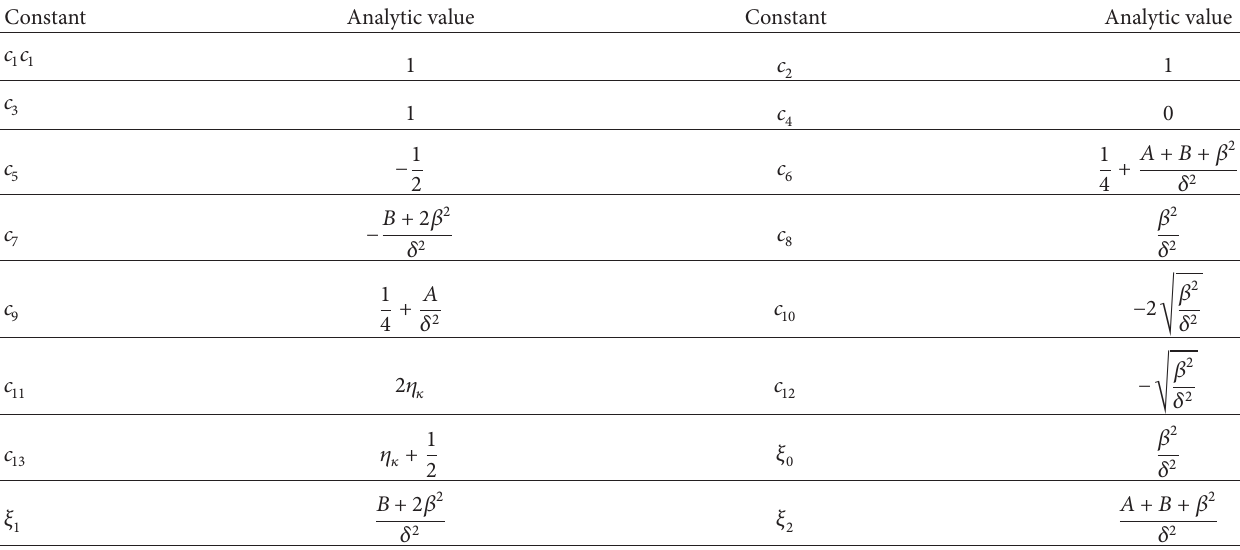
Table 2: The specific values for the parametric constants necessary for calculating the energy eigenvalues and eigenfunctions of the spin symmetry